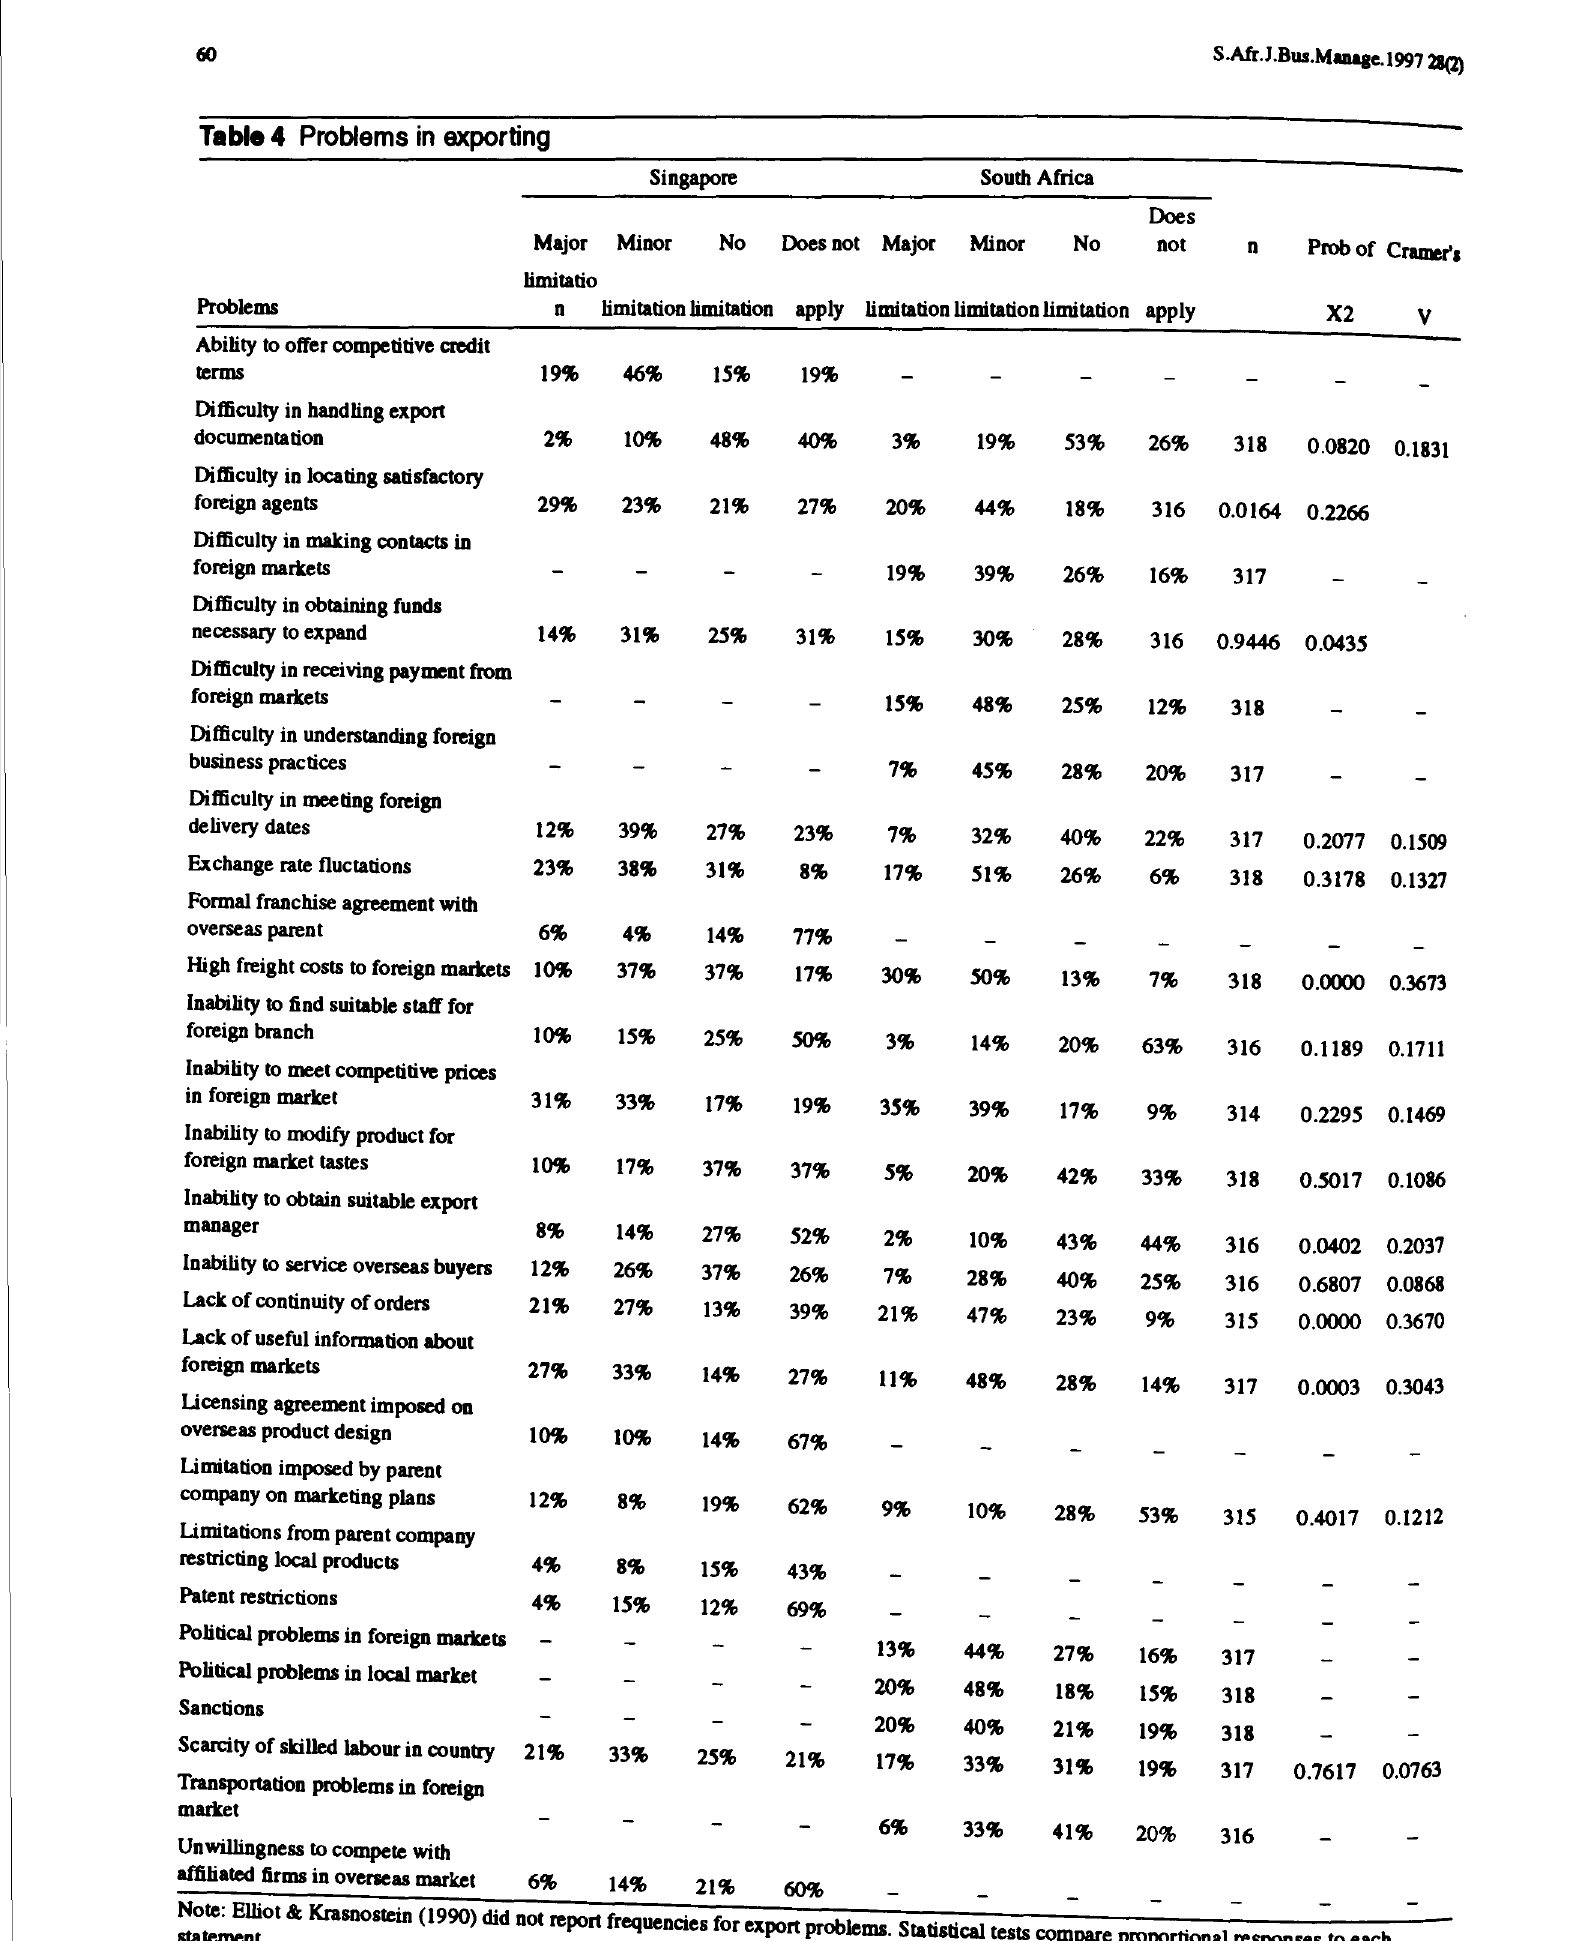
Table 4 Problems in